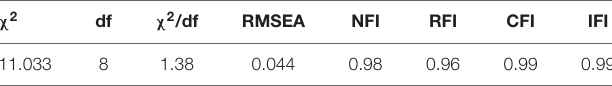
TABLE 4 | Results of confirmatory factor analysis of the CINL